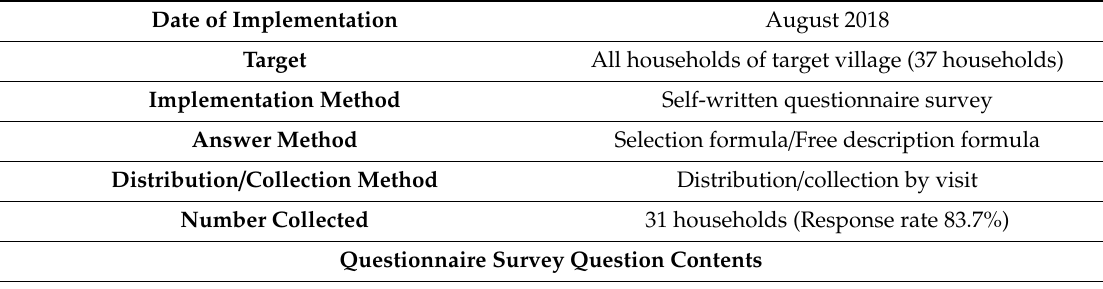
Table 3. Outline of the questionnaire survey.